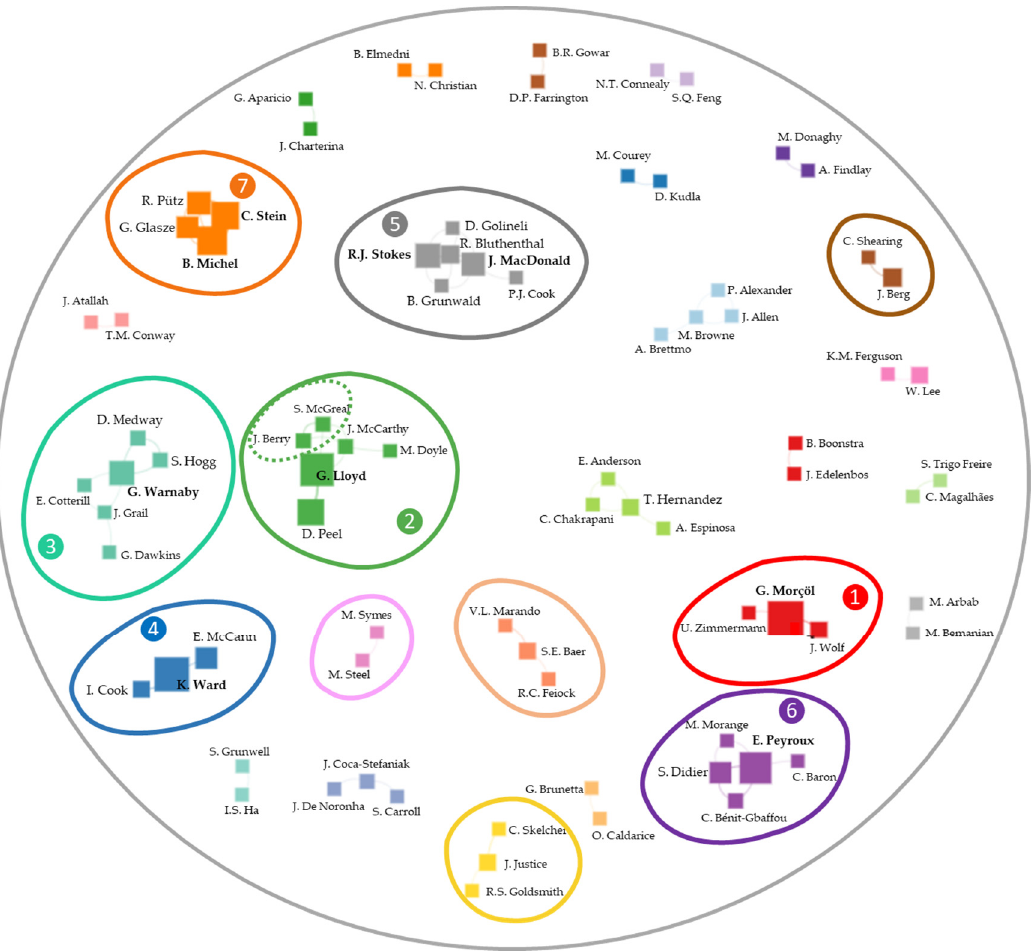
Figure 5. Author Collaboration Networks. Highlighted clusters contain, at least, the existence of two